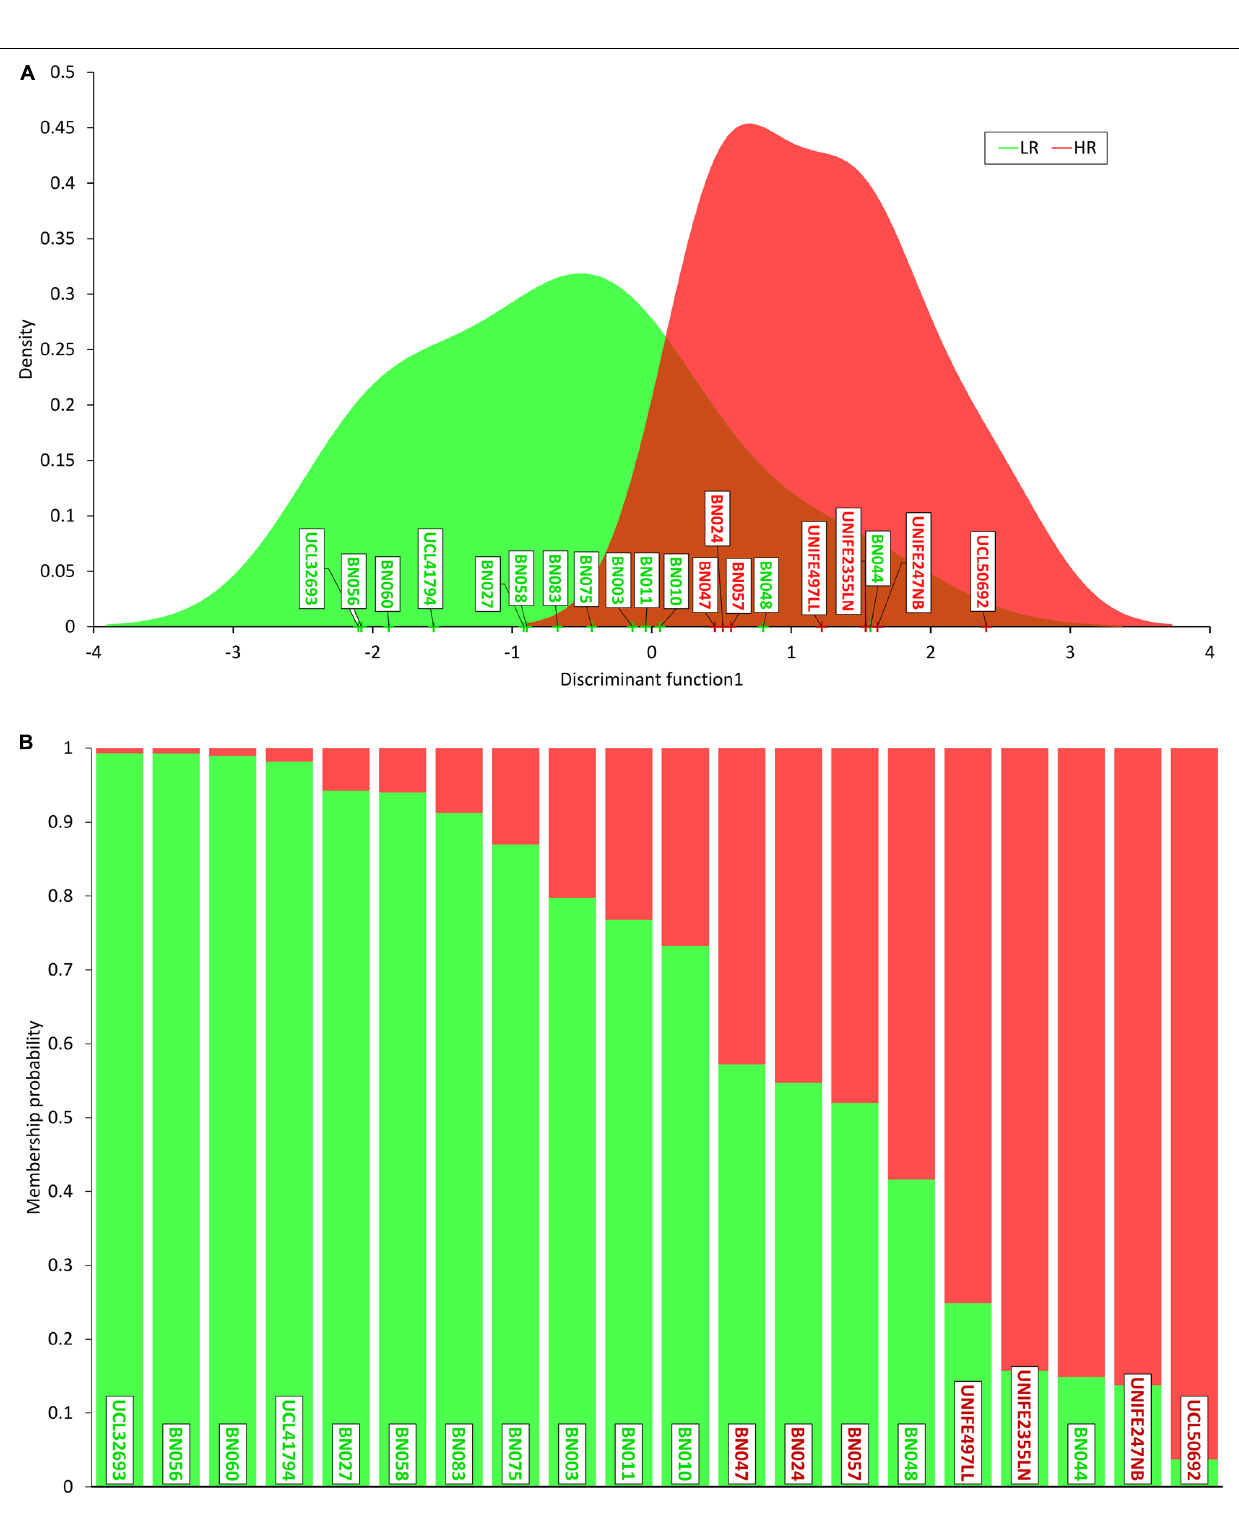
Frontiers in Genetics |